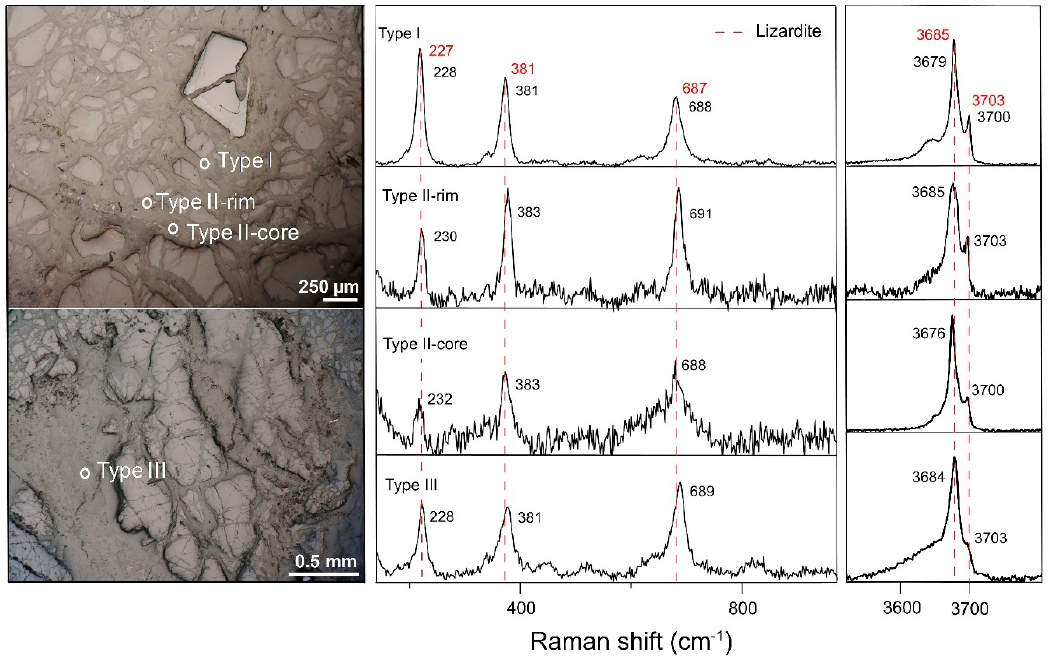
Figure 7. Raman signatures of type I, type II and type III vein serpentines identified in the lherzolite bedrock. Red dashed lines indicate the Raman bands from previous work [21].